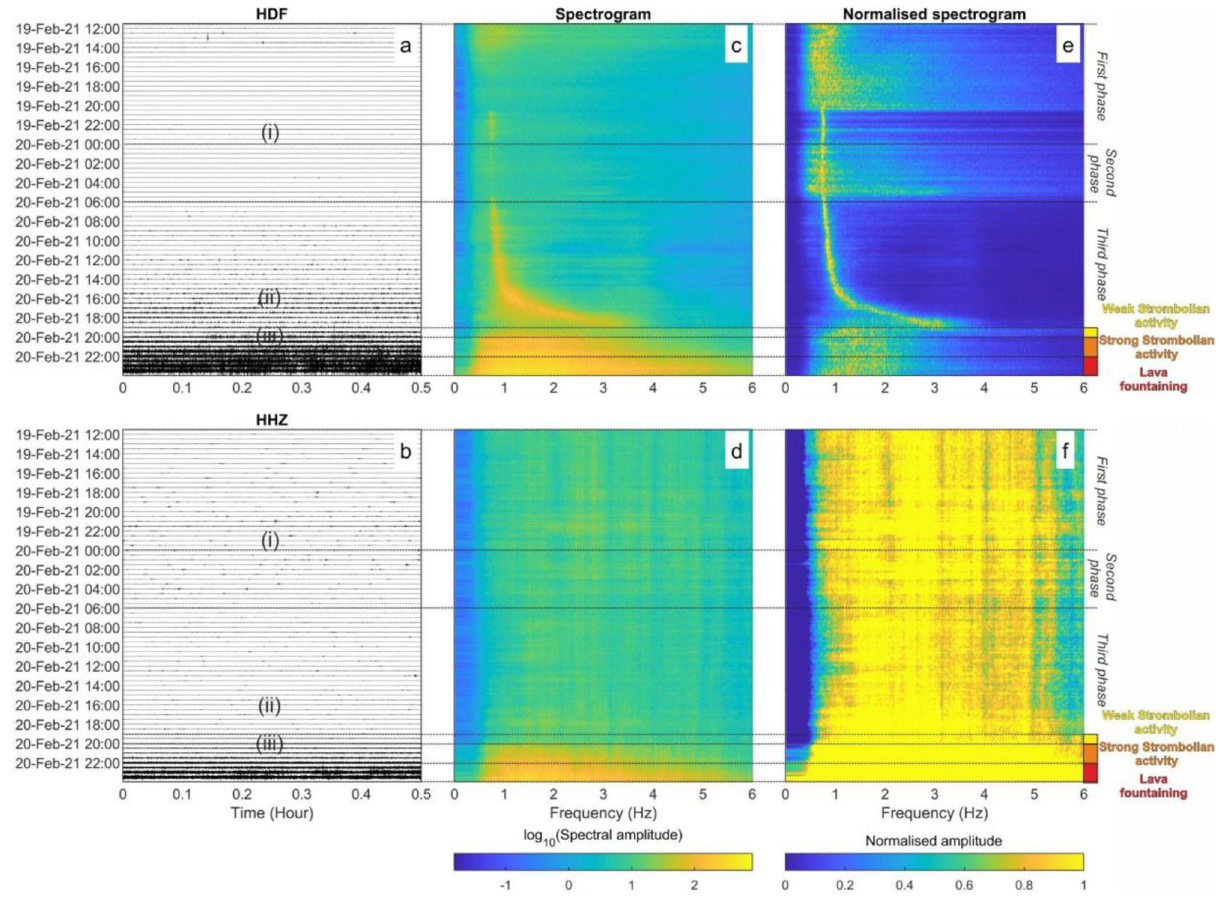
Figure 2. 36 h of seismo-acoustic records from 19 February at 12:00 to 21 February at 00:00 recorded by ECPN. ( a ) Infrasonic signal and ( b ) vertical component of the seismic signal. ( c , d ) Corresponding spectrograms and ( e , f ) normalized spectrograms computed for hour-long intervals. The symbols (i), (ii) and (iii) in ( a , b ) show the time intervals when the signals shown in Fig. 3 were recorded. The black dotted lines show